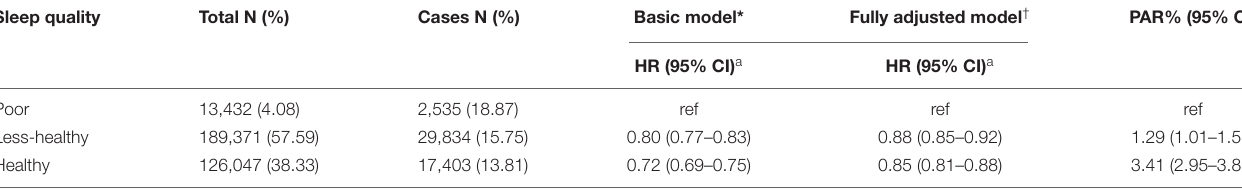
TABLE 2 | Associations for sleep quality with risk of terminated health span among 328,850 participants. Sleep quality